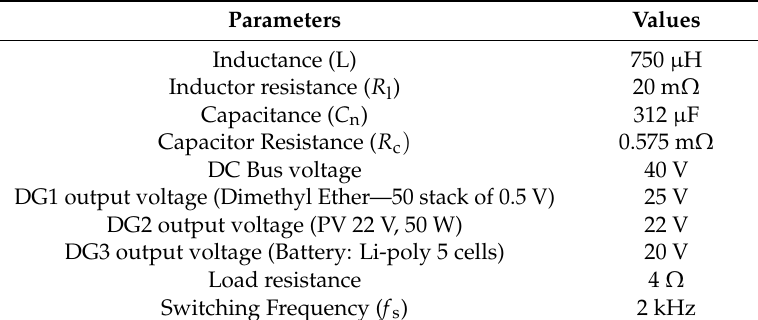
Table 1. DC power network parameters.